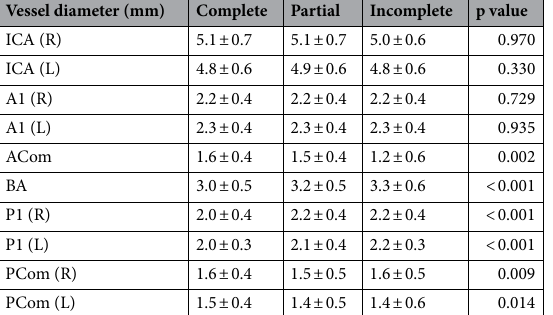
Table 6. Vessel diameters according to configuration of COW * . *Circle of